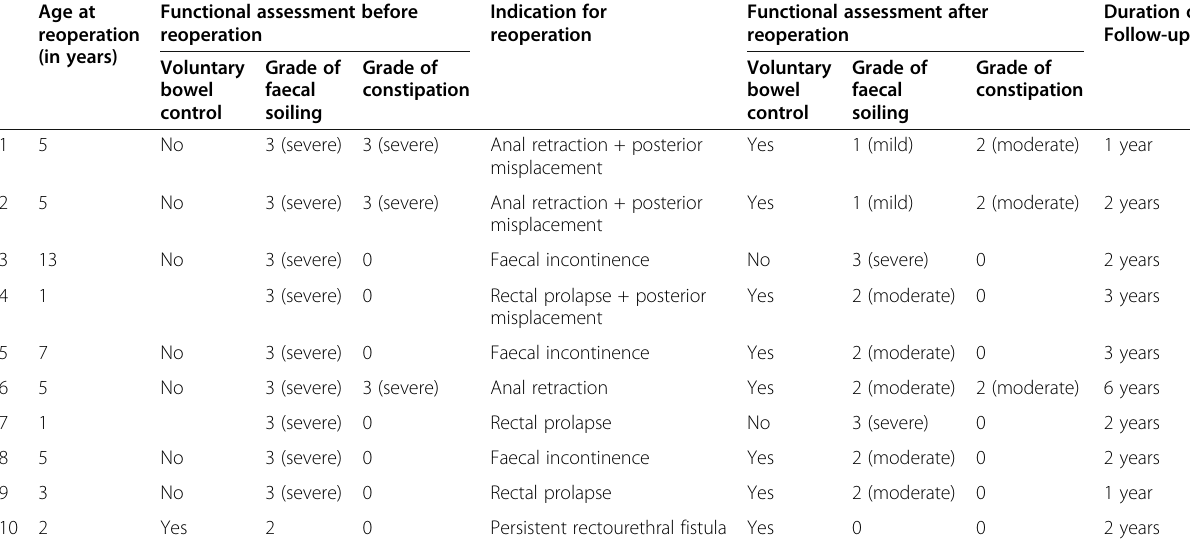
Table 3 The functional assessment (continence) before and after reoperation in group B Age at reoperation (in